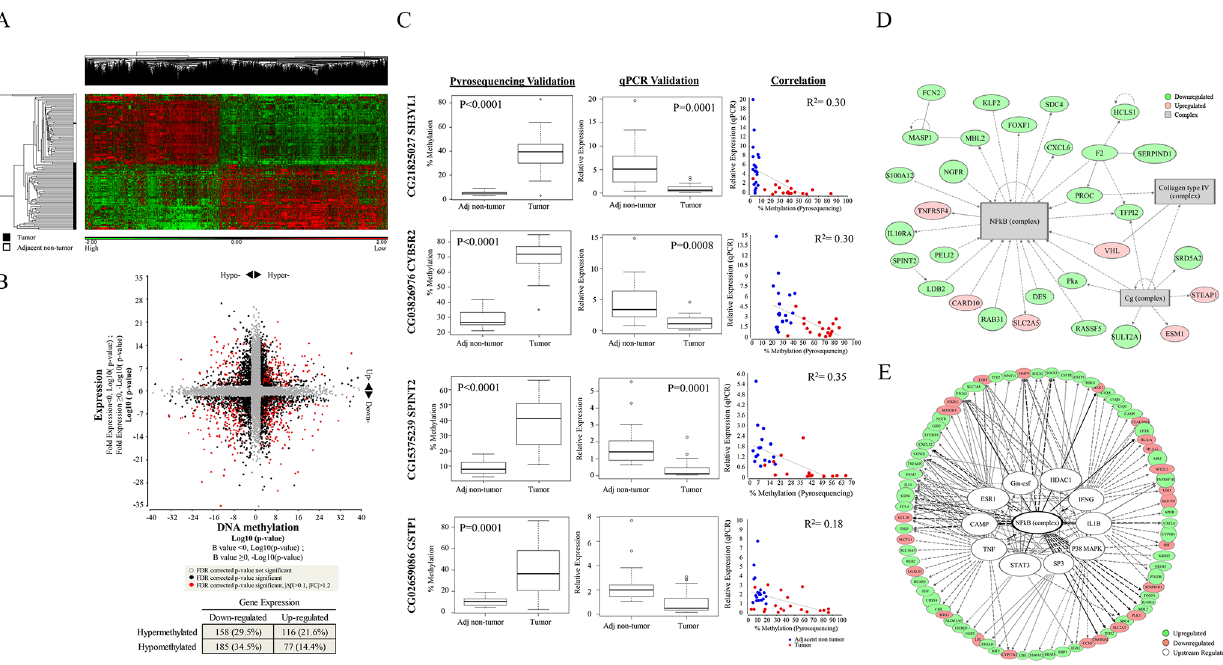
Figure 4. Integrated analysis of methylation and gene expression in 59 HCC patients. (A) Hierarchical clustering of the 3185 most significantly differentially expressed genes between tumors and adjacent non-tumorous tissues. (B) Starburst plot was constructed by plotting transformed log10 p-value of differentially expressed genes (Y-axis) versus transformed log10 p-value of methylation difference (X-axis) between tumor and adjacent non-tumorous tissues. Genes with FDR adjusted p-value , 0.05 were labeled in black. Genes with absolute fold change . 1.2, difference in b -value greater than 0.1 and which met the statistical cut-off (FDR adjusted p-value , 0.05) were labeled in red. Directional change of expression and methylation are indicated by the black arrow head. Table at lower panel shows the percentage of genes with significant positive and negative correlations between gene expression and methylation data. (C) Validation results for SH3YL1, CYB5R2, SPINT2 and GSTP1. Methylation and gene expression data were validated by pyrosequencing and quantitative PCR respectively. T-test was used to compare the difference in methylation or gene expression between two groups; Pearson correlation was used to measure association between pyrosequencing and Infinium data, and between gene expression and methylation data. (D) Top network derived from the 536 aberrantly methylated and deregulated genes where NF k B complex served as primary node. (E) Predicted upstream regulators from IPA. Eleven upstream regulators (including NF k B complex) were associated with the NF k B pathway. Red spheres indicate genes that were upregulated in tumor; green spheres indicate downregulated genes in tumor compared to adjacent non-tumorous tissues; grey boxes represent complexes and white spheres represent upstream regulators.